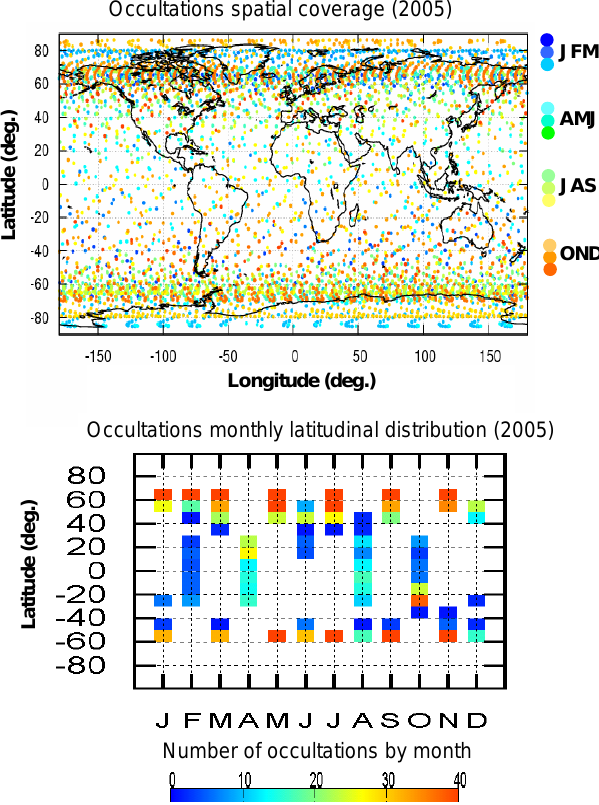
Fig. 2. Locations of ACE-FTS occultations available in 2005 per month (color scale) (top); monthly distribution of the number of occultations per 10 ◦ latitude band